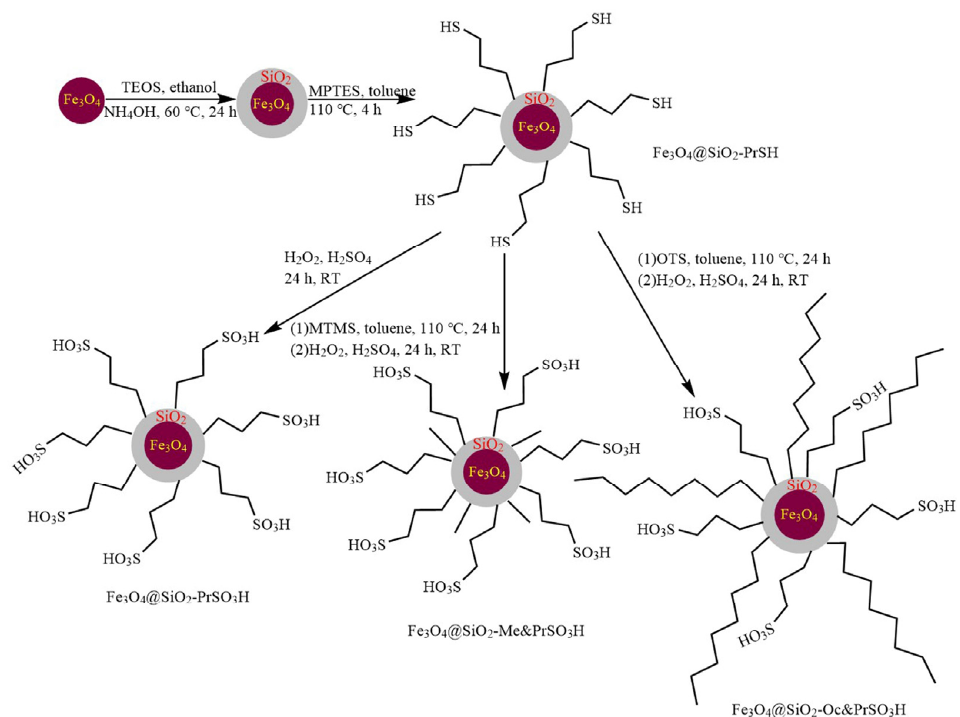
Figure 1. Preparation process of catalysts Fe 3 O 4 @SiO 2 -PrSO 3 H, Fe 3 O 4 @SiO 2 -Me&PrSO 3 H and Fe 3 O 4 @SiO 2 -Oc&PrSO 3